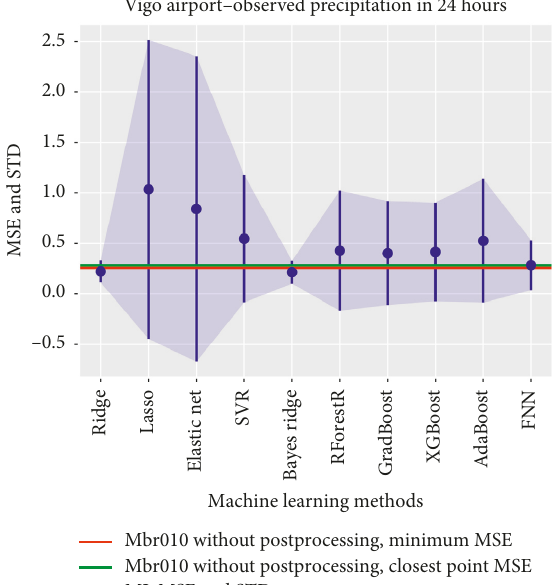
Figure 26: Precipitation in 24 hours, standardized calibration plot for Vigo airport. Horizontal axis as in Figure 18.